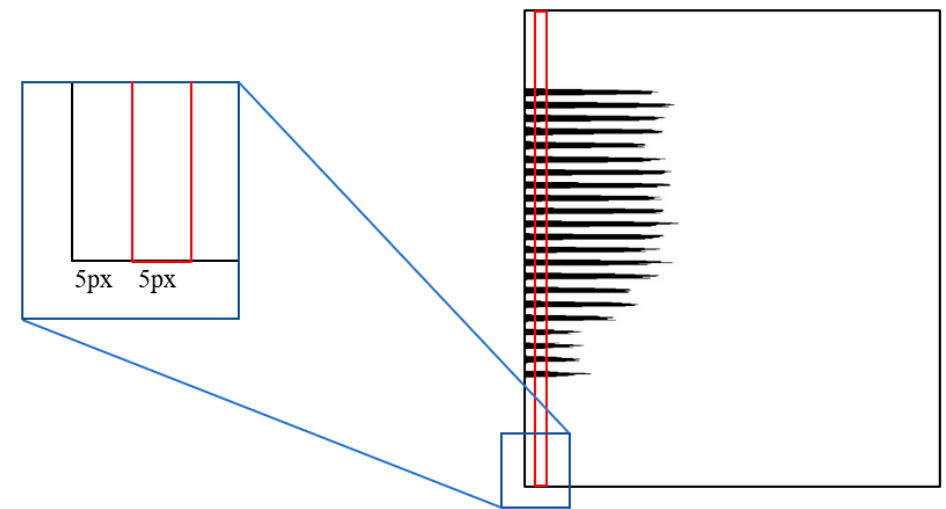
Figure 5. Valley value calculation area. Red box: Valley value calculation area (A rectangular area with a width of five pixels) Black pixel: The foreground pixel (Obtained by projecting the text area to the horizontal direction). The vertical axis of the projection profile image corresponds to the vertical axis of the original image, and its horizontal axis is the accumulated value of the foreground pixel on the vertical axis.